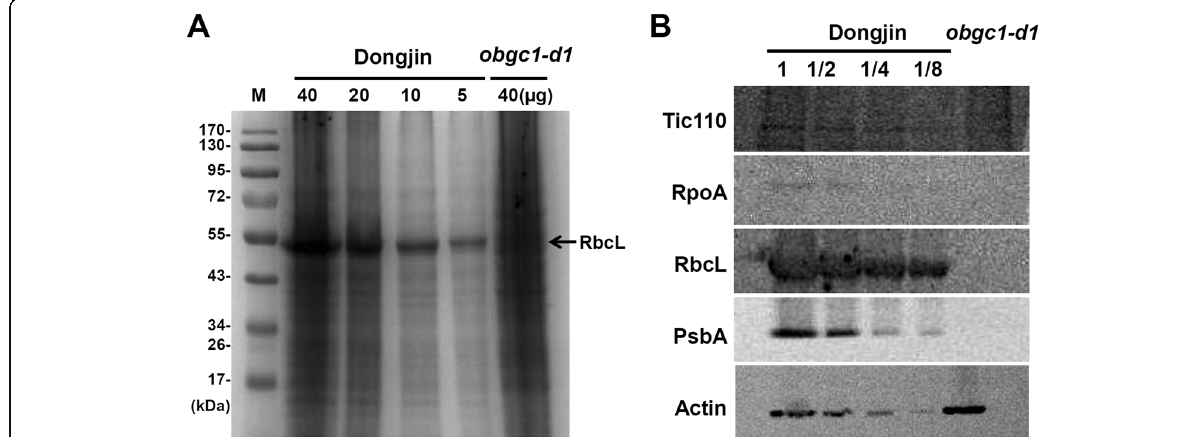
Fig. 8 Chloroplast protein accumulation in obgc1-d1 mutant. Immunoblot analysis compares accumulation of the proteins in obgc1-d1 and a series of diluted wild-type proteins. A Confirmation of gel loading amounts of wild-type and obgc1-d1 mutant proteins. B Total leaf extracts (40 μ g of protein or its serial dilution as indicated) were hybridized with the respective antibodies against Tic110, RpoA, RbcL, PsbA and Actin. Tic110 and Actin levels were used as internal controls to normalize the amount of total